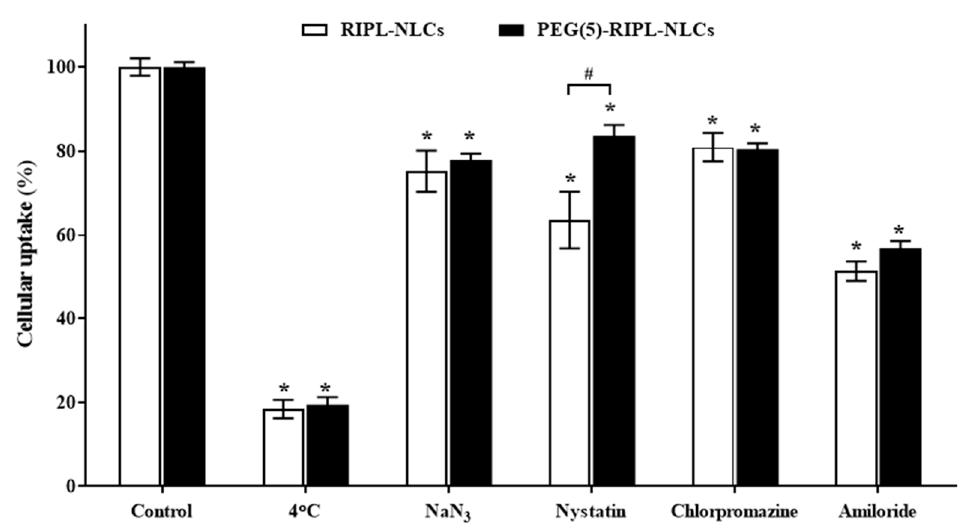
Figure 6. Competitive inhibition study of cellular uptake of RIPL-NLCs and PEG(5)-RIPL-NLCs by SKOV3 cells in the presence of endocytosis inhibitors and at a low temperature. Data are the mean ± SD ( n = 3). * p < 0.05 versus control; # p < 0.05 between RIPL-NLCs and PEG(5)-RIPL-NLCs.